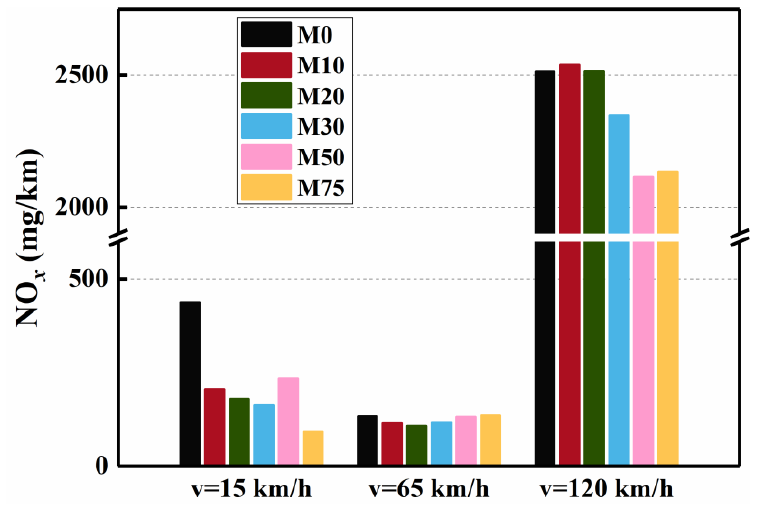
Figure 5. Effects of different methanol blending ratios on NO x emissions at different vehicle speeds.